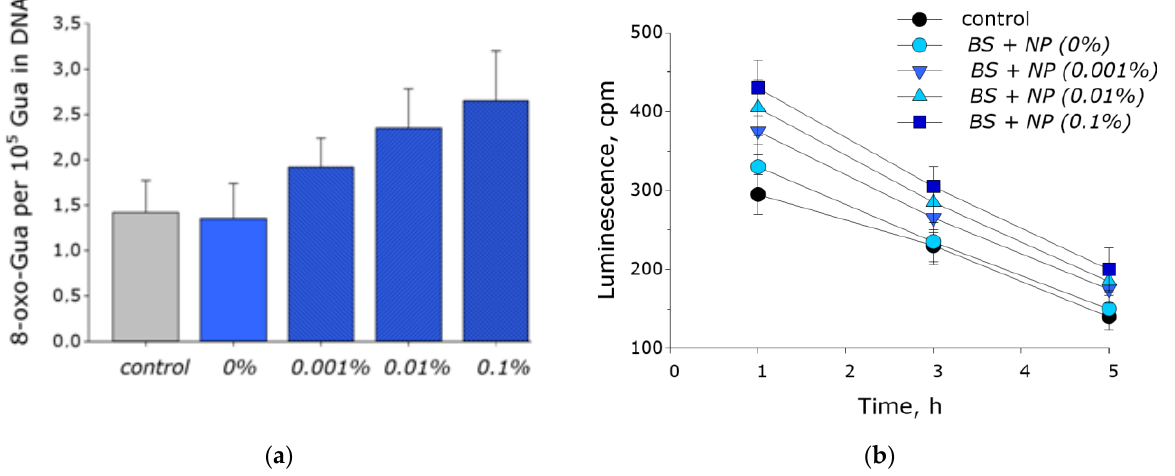
Figure 8. Effect of composite material containing PLGA and Al 2 O 3 NPs on the biomacromolecules damage formation: ( a ) Generation of 8-oxo-Gua in DNA in vitro (2 h, 45 °C); ( b ) Generation and damage formation: ( a ) Generation of 8-oxo-Gua in DNA in vitro (2 h, 45 ◦ C); ( b ) Generation and dynamics of decomposition of LRPS (2 h, 40 °C); Data are presented as mean values and standard dynamics of decomposition of LRPS (2 h, 40 ◦ C); Data are presented as mean values and standard errors of mean. errors of mean.